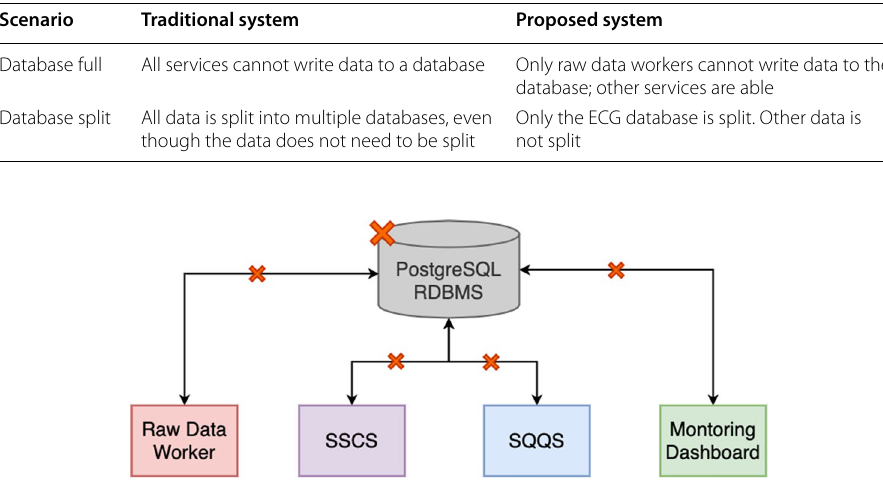
Fig. 15 Proposed system when database failed